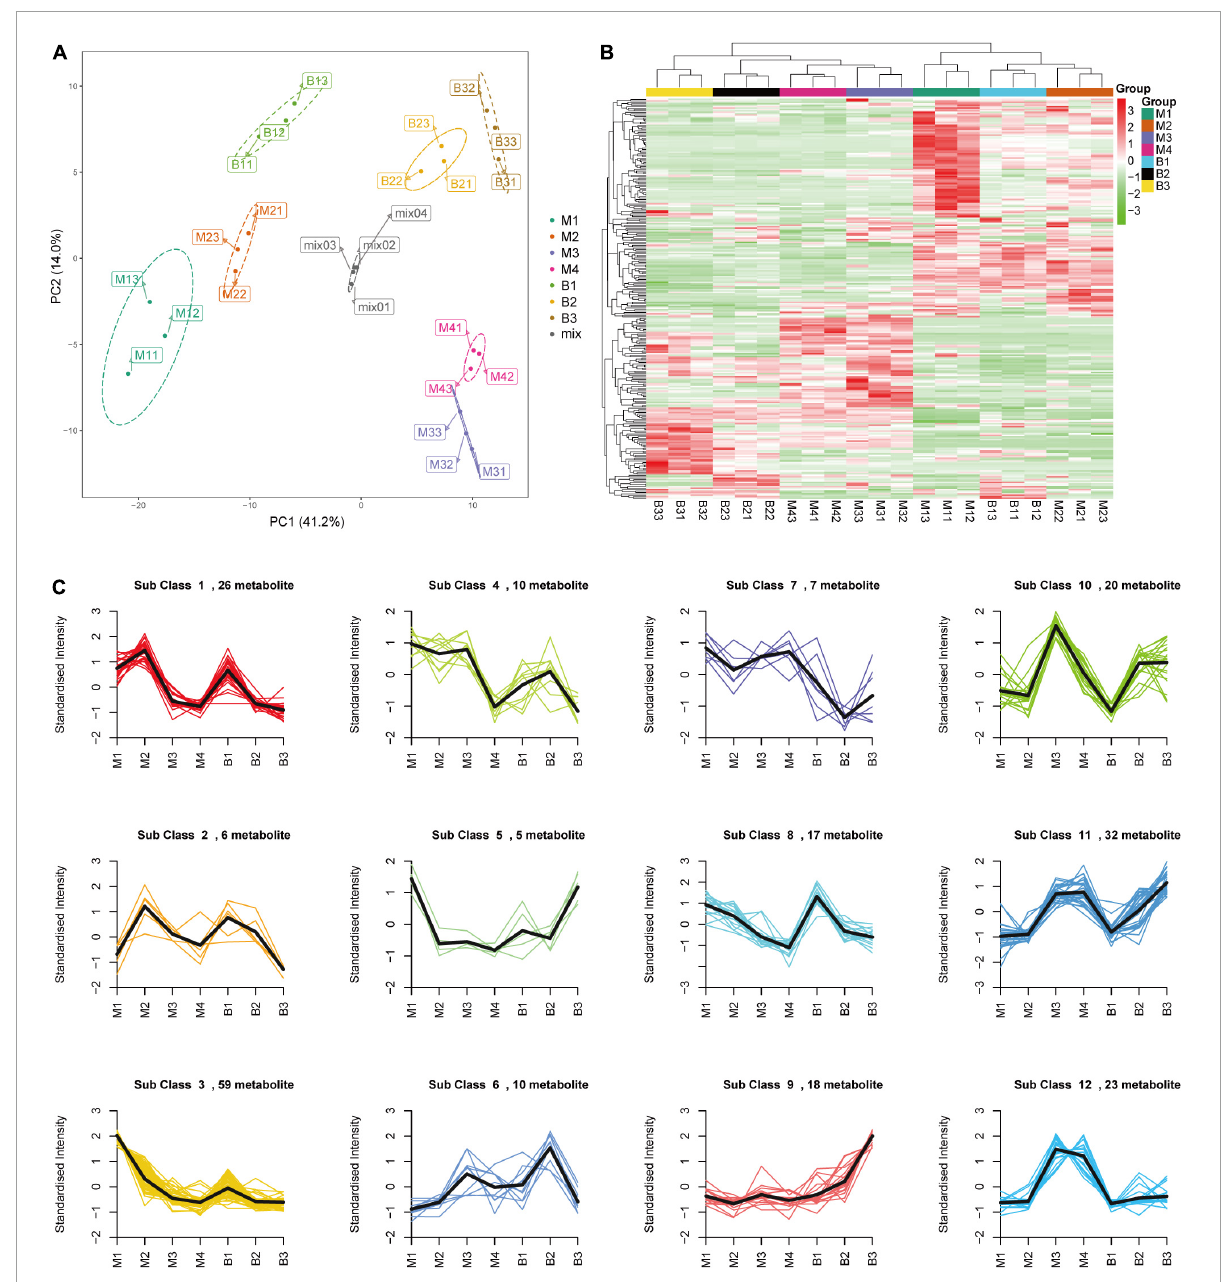
FIGURE2 PCA (A) , HCA (B) , and K-means clustering (C) of the metabolites from the developing pineapple flesh. M1, M2, M3, and M4 represented fruit flesh samples for M at 40, 80, 100, and 120 DAA, respectively, B1, B2, and B3 represented fruit flesh samples for B at 40, 80, and 100 DAA, respectively. In the heatmap, each sample was represented by a single column, and each metabolite was visualized in a row. Red showed high abundance, and green exhibited relatively low metabolite abundance. 12 clusters (Sub class 1–12) of 233 differential metabolites were divided based on the dynamic changes of metabolites from different developmental stages for the two